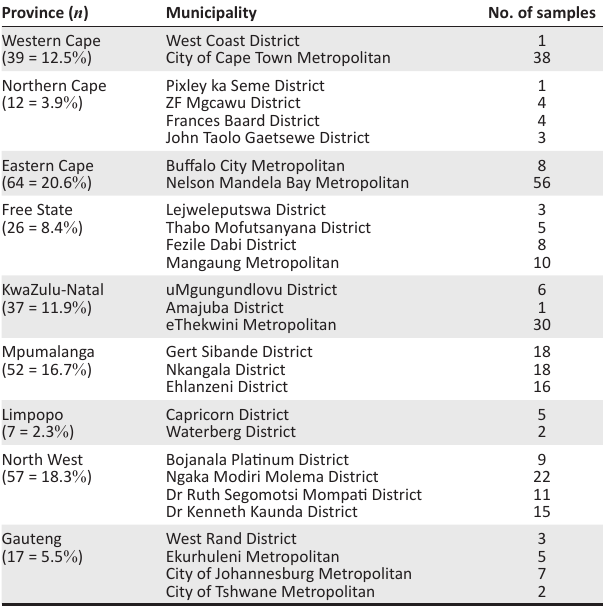
TABLE 1: Origin and number of poultry meat samples collected from 2015 to